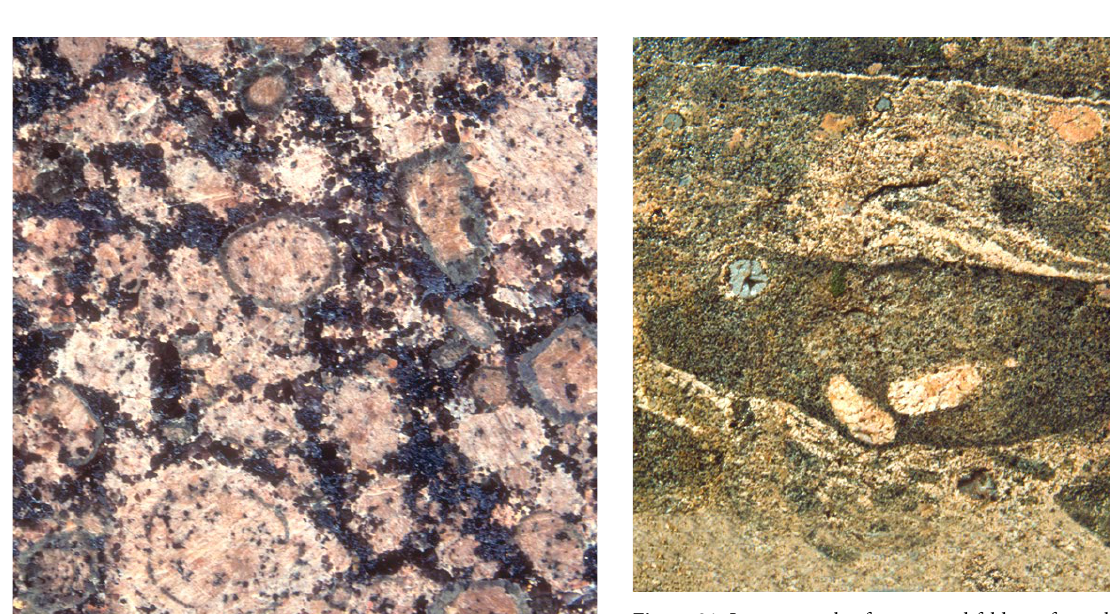
Figure 31. Large crystals of quartz and feldspar from the surround- ing granite matrix are found embedded in fragments and wall rock. This double-enclosure problem is inconsistent with molten rock